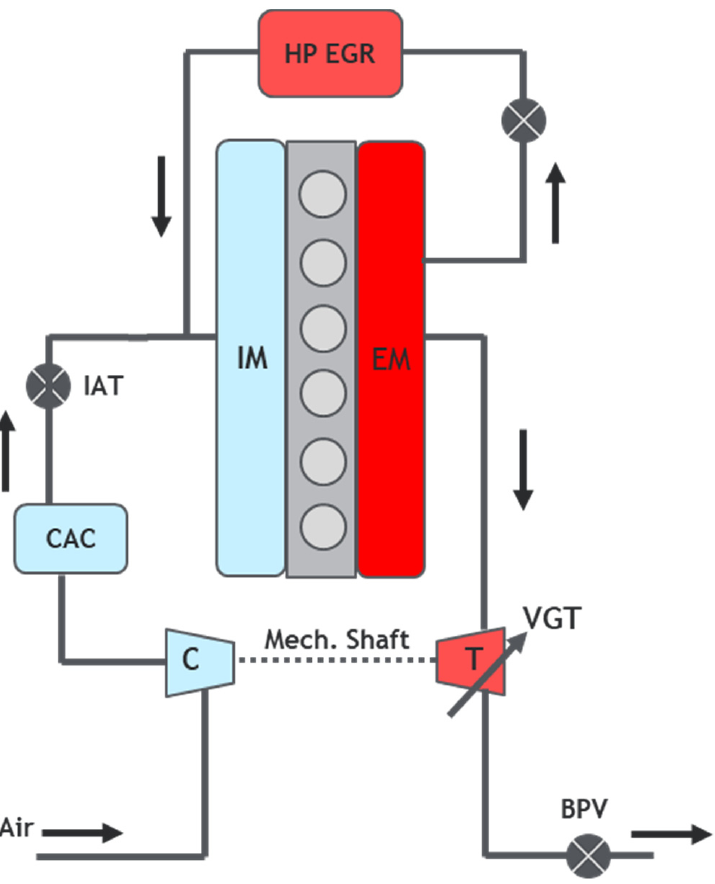
Figure 1. Schematic of the HD GCI engine configuration.